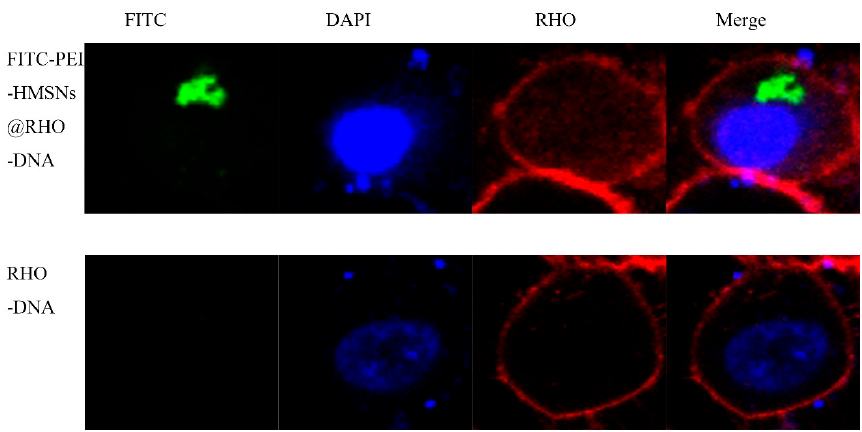
Figure 6. Confocal microscopy images of Lovo cells incubated with RHO-DNA and FITC-PEI-HMSNs for 4 h at 37 °C. Cell nuclei were stained blue with DAPI, RHO-DNA were stained red with rhodamine phalloidin, and FITC was shown as green fluorescence.